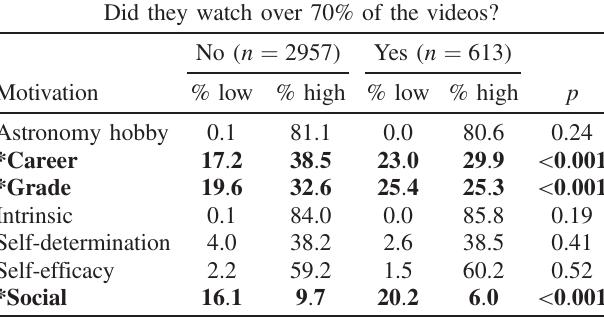
TABLE VI. Percentages of learners in the low and high tiers of each motivational category for those who did not watch more than 70% of videos and for those who did. Statistically significant results at the p ¼ 0 . 05 level using the Kolmogorov-Smirnov two sample test are denoted with asterisks and in bold type.